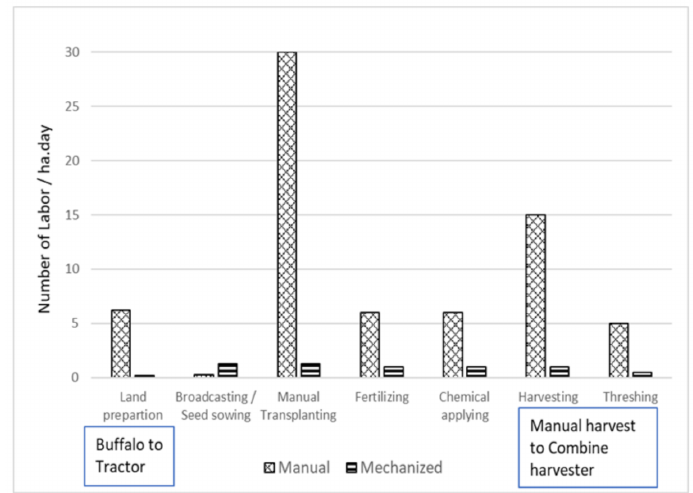
Figure 12. Required number of labor for one ha, done in one day for each process of rice